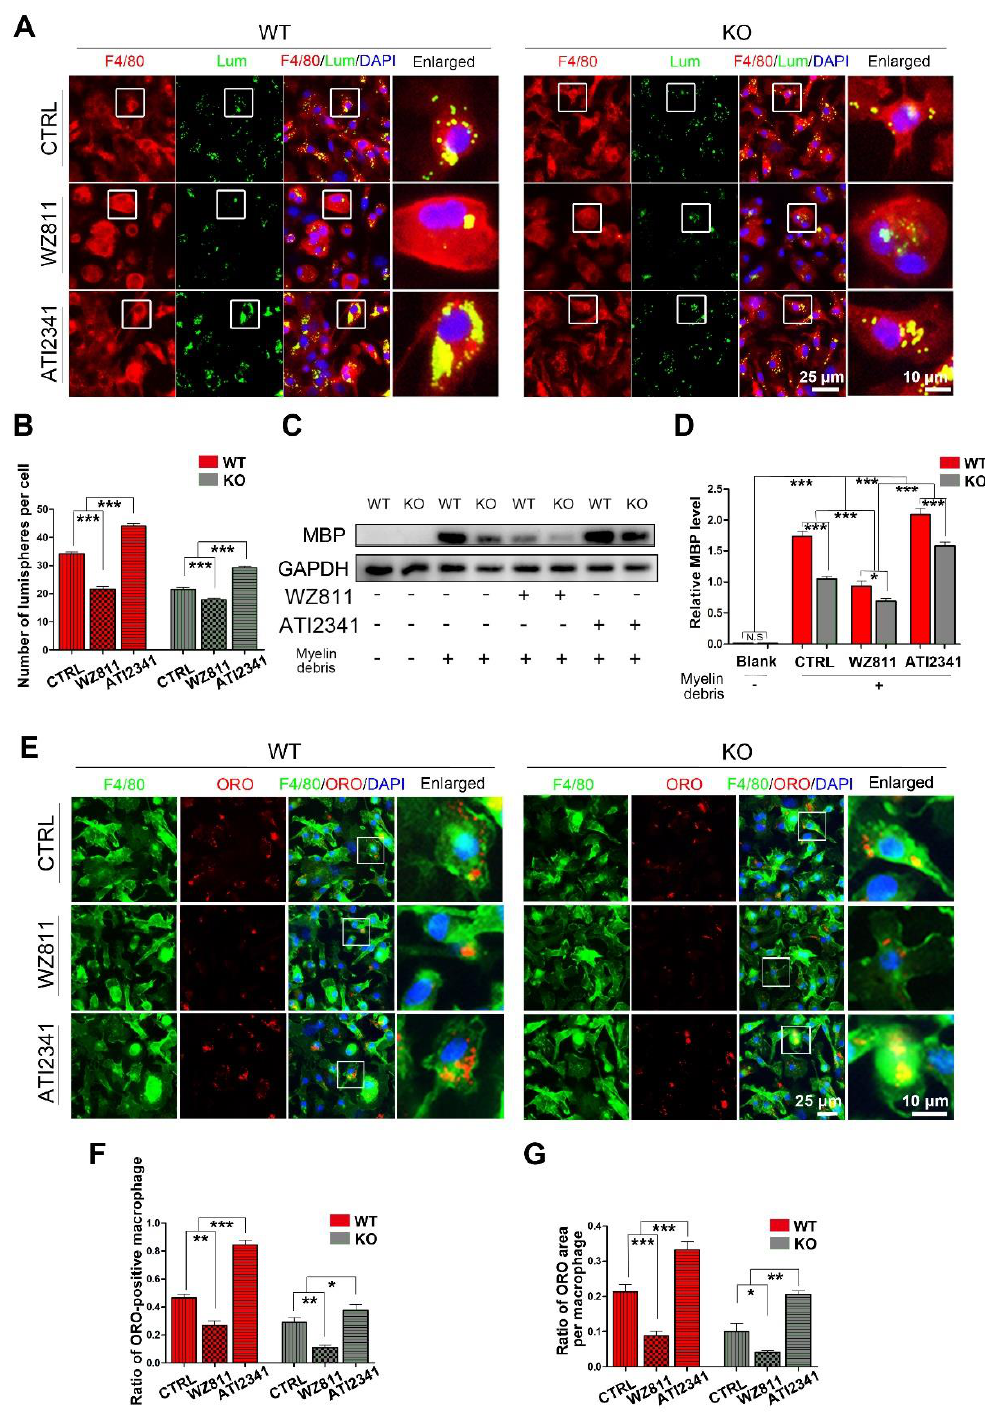
Figure 6. The CXCR4 inhibitor (WZ811) and agonist (ATI2341) regulate macrophage phagocytosis. ( A ) F4/80 immunocytochemistry with the fluorescent lumispheres and ( B ) quantitative analysis. ( C , D ) Western blots and quantification showing the ingested MBP expression in vitro. ( E ) F4/80 and ORO double immunocytochemistry staining and ( F , G ) quantification of the ratio of ORO+ macrophages and the ORO+ area in each cell after the macrophages cultured with myelin debris in vitro. Data are expressed as the mean ± SEM ( n = 3 for each group, N.S p ≥ 0.05, * p < 0.05, ** p < 0.01, *** p < 0.001).